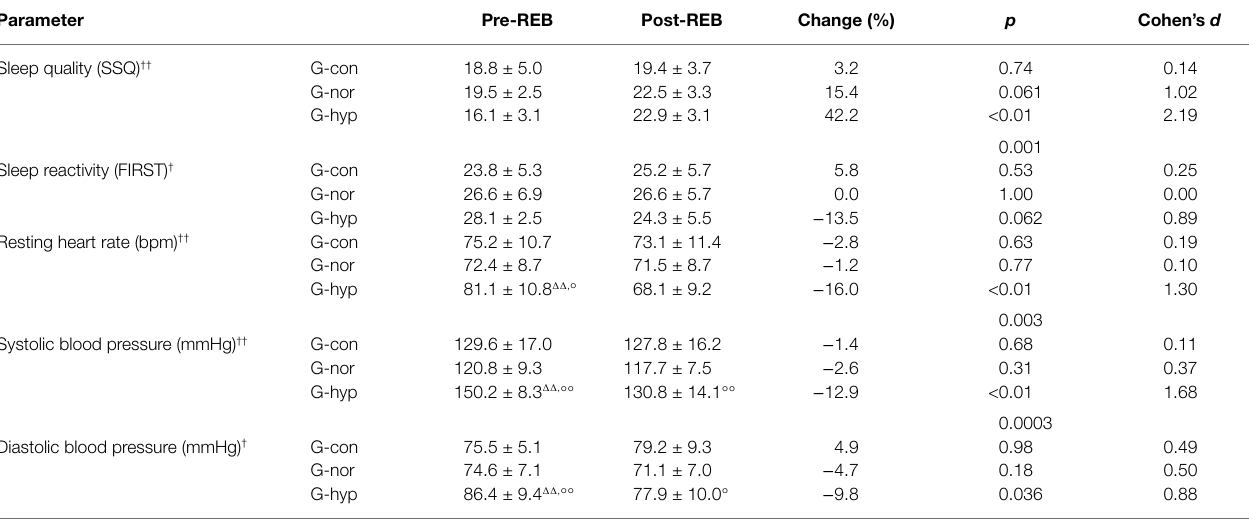
TABLE 2 | Changes in sleep quality, sleep reactivity, resting heart rate, and blood pressure before and after the Rebalance© Program (mean ± SD). Parameter